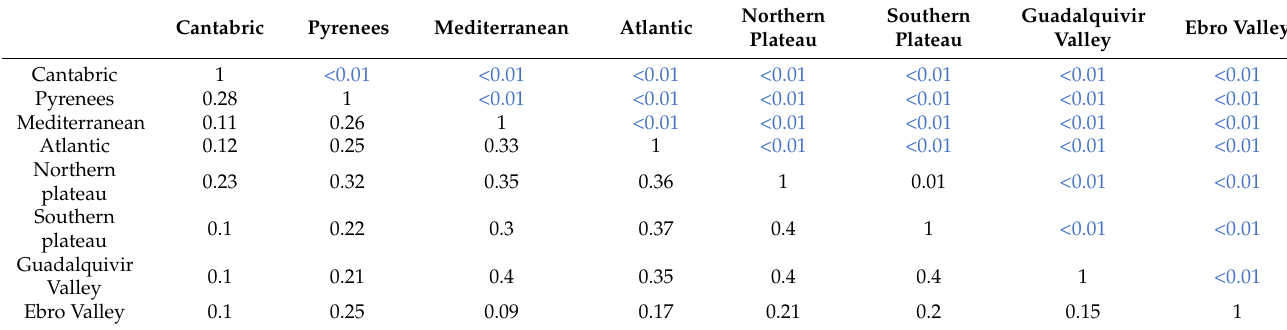
Table 3. Jaccard’s Index (black numbers) and probability associated to significant differences (blue numbers) amongst the occurrence of species in paired refugium areas of the